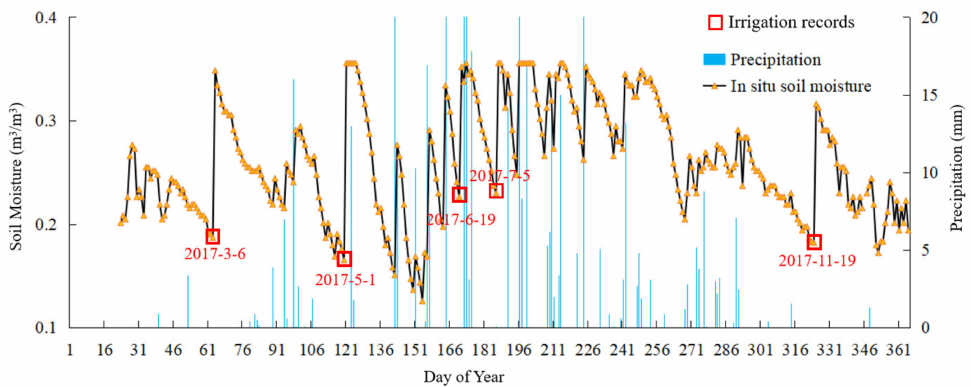
Figure 3. Daily soil moisture and precipitation (53990,